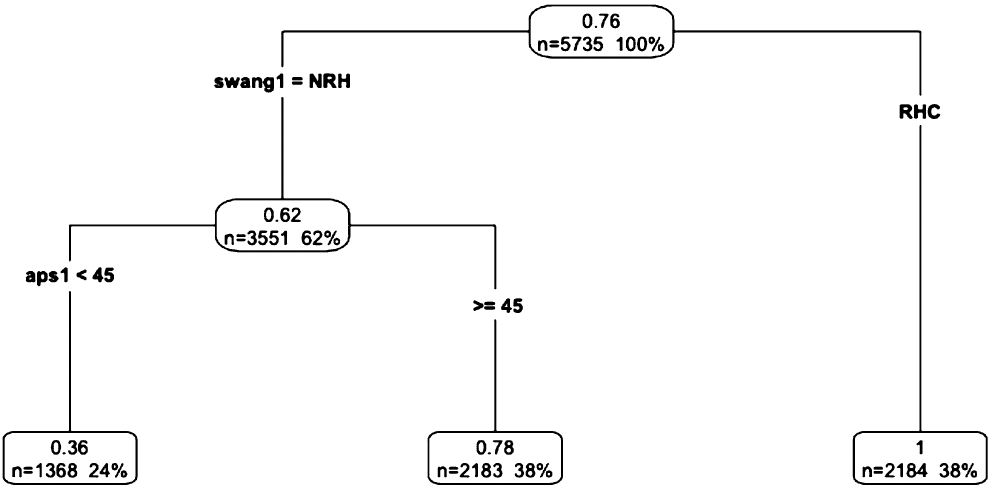
Figure 1: Tree plot from modelling being in the margin as a function of the covariates in the SUPPORT study. The tree was pruned using a cost-complexity parameter of